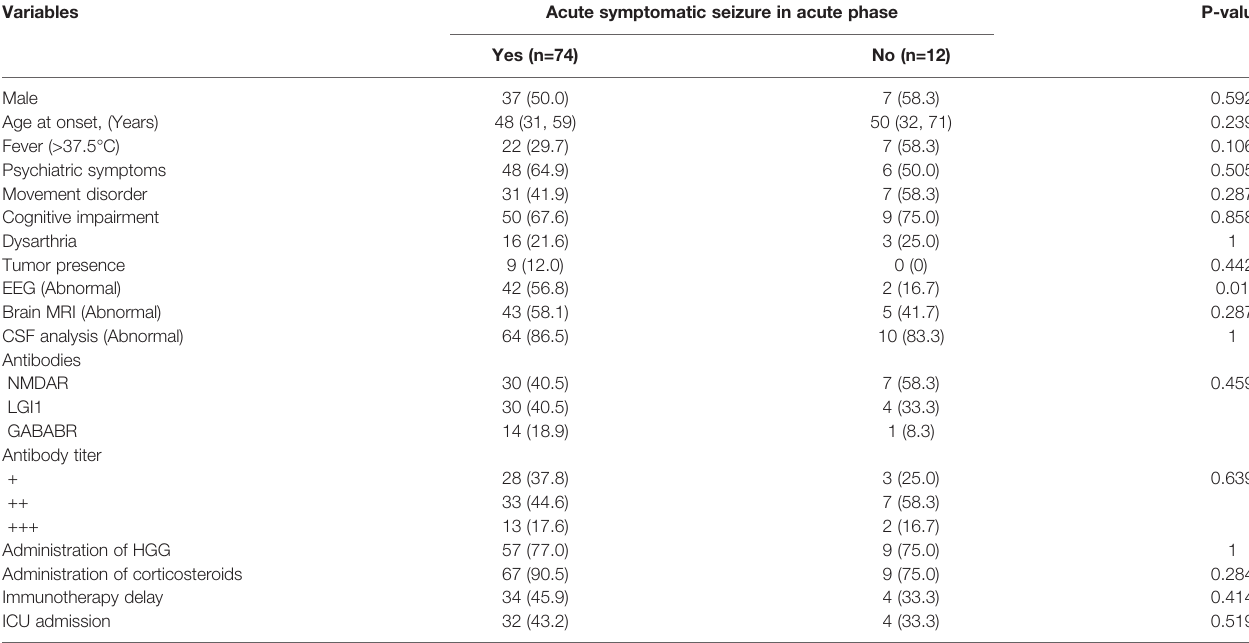
TABLE 3 | Univariate analysis of factors associated with acute symptomatic seizures in total AE patients.